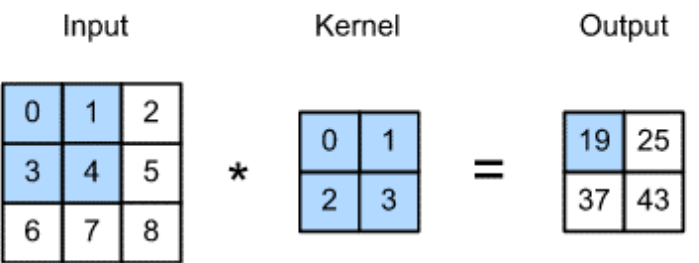
Figure 4. Convolutional example using a 2 × 2